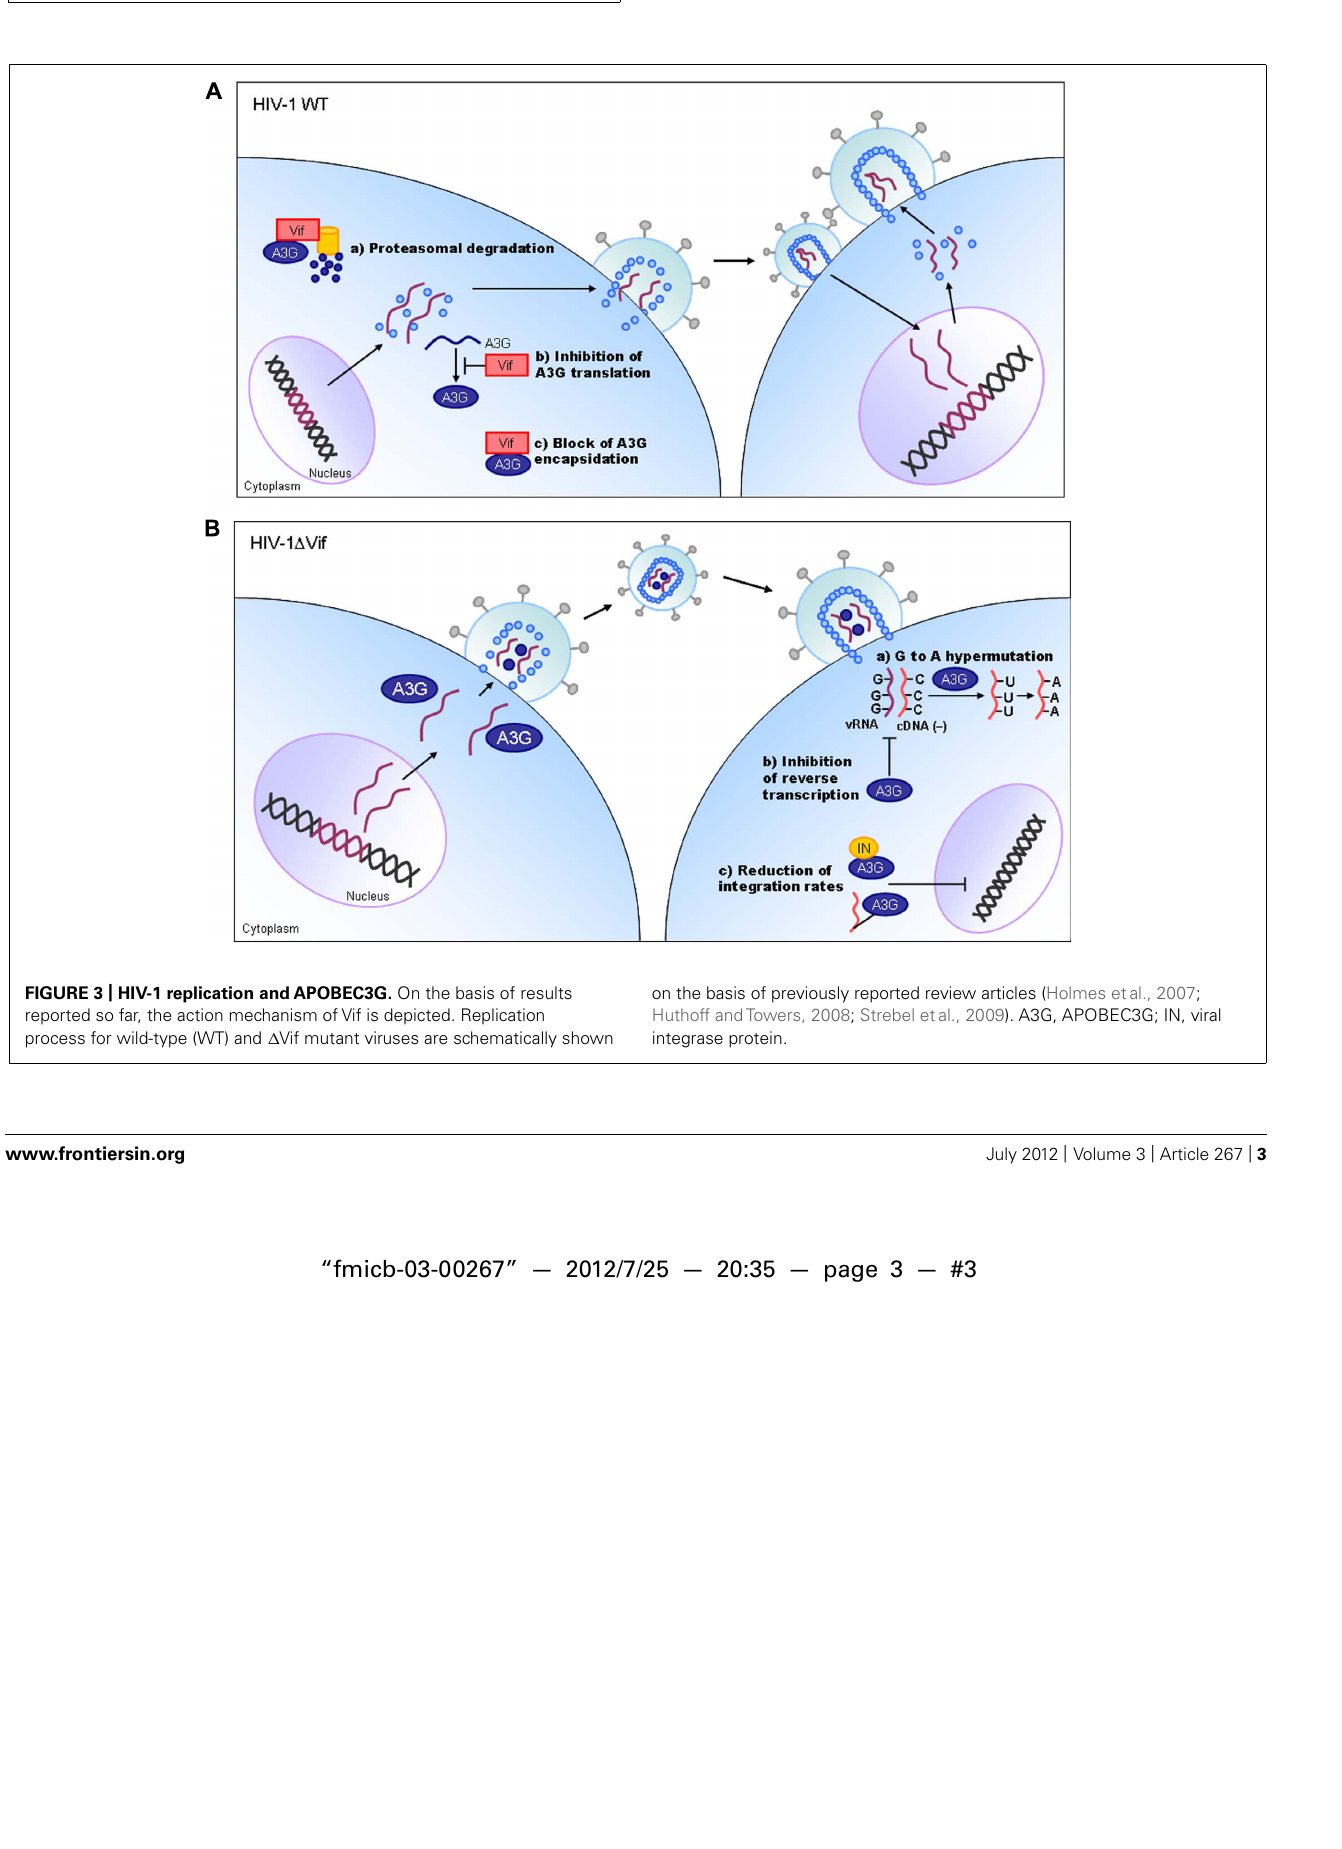
FIGURE 2 |A schema of replication kinetics by HIV-1 wild-type and mutant viruses. Viral growth properties in cells are illustrated based on numerous infection experiments in our laboratory.WT, wild-type.